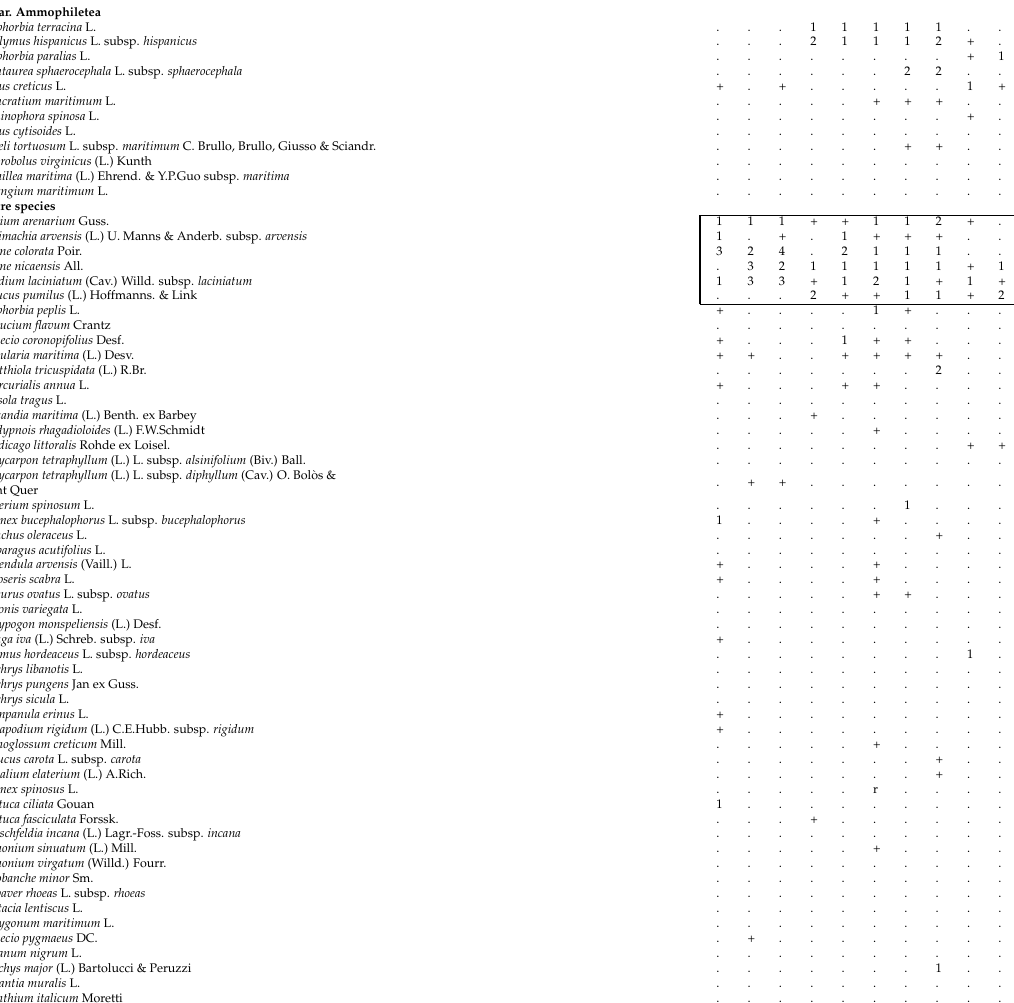
Char. Ammophiletea Euphorbiaterracina